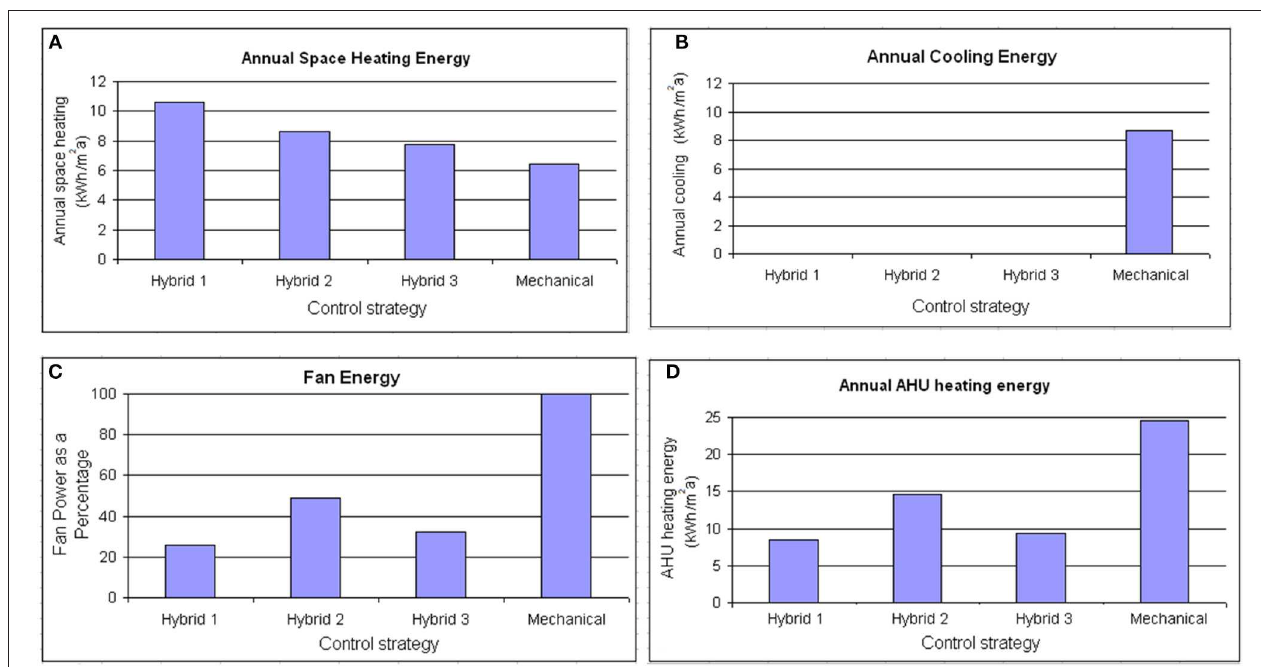
FIGURE 7 | Comparison of the investigated ventilation strategies: (A) Annual space heating energy. (B) Annual cooling energy. (C) Annual AHU fan energy assuming constant fan efficiency. (D) Annual AHU heating energy neglecting the heat recovery.